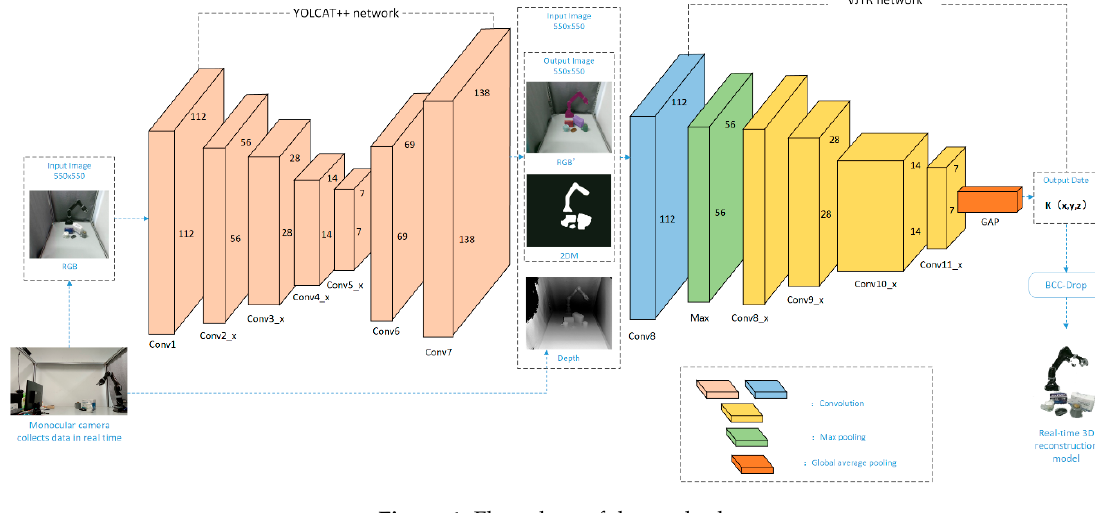
Figure 1. Flow chart of the method.